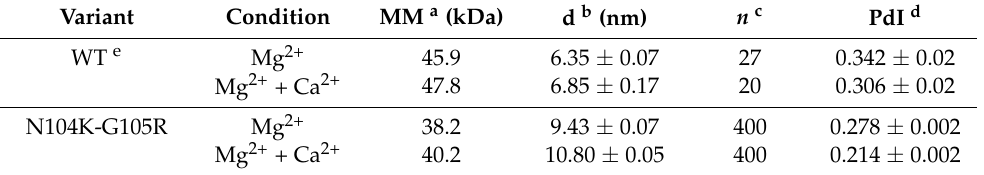
Table 2. Variations of the apparent molecular mass (MM) and hydrodynamic diameter of GCAP1 variants assessed by analytical Size Exclusion Chromatography (SEC) and Dynamic Light Scattering (DLS)